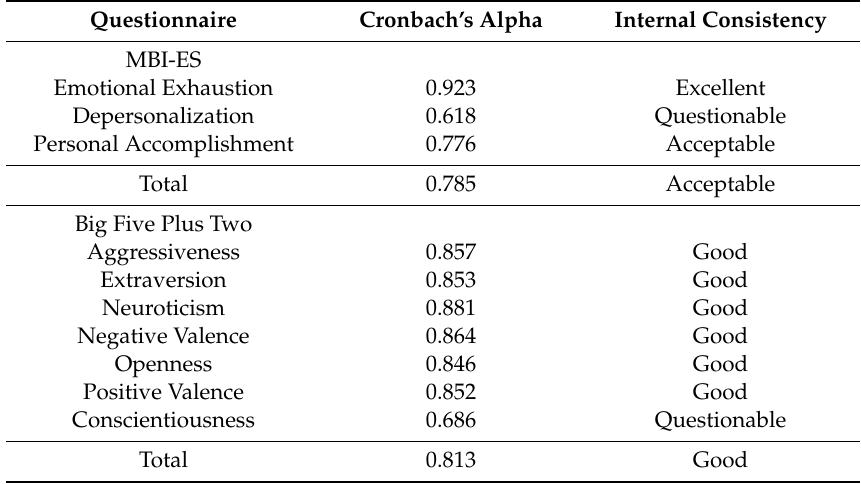
Table 2. Reliability Statistics for MBI-ES and Big Five Plus Two (Big 5 + 2) questionnaire.